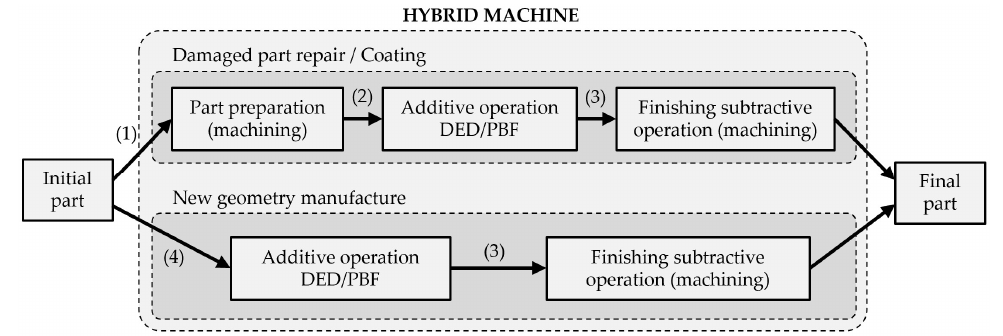
Figure 10. Process interactions within a hybrid Figure 10 . Process interactions within a hybrid machine.